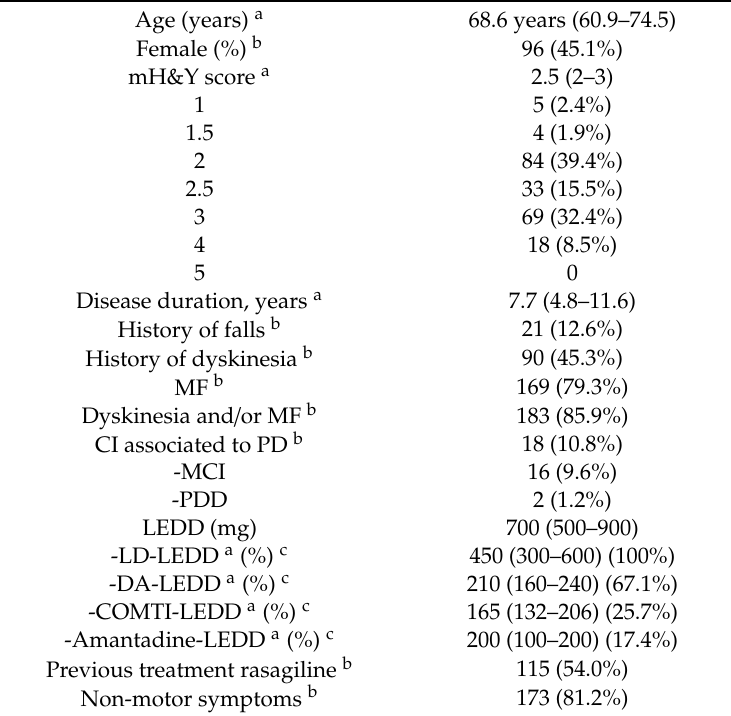
Table 1. Demographic and clinical data at baseline visit ( n = 213).